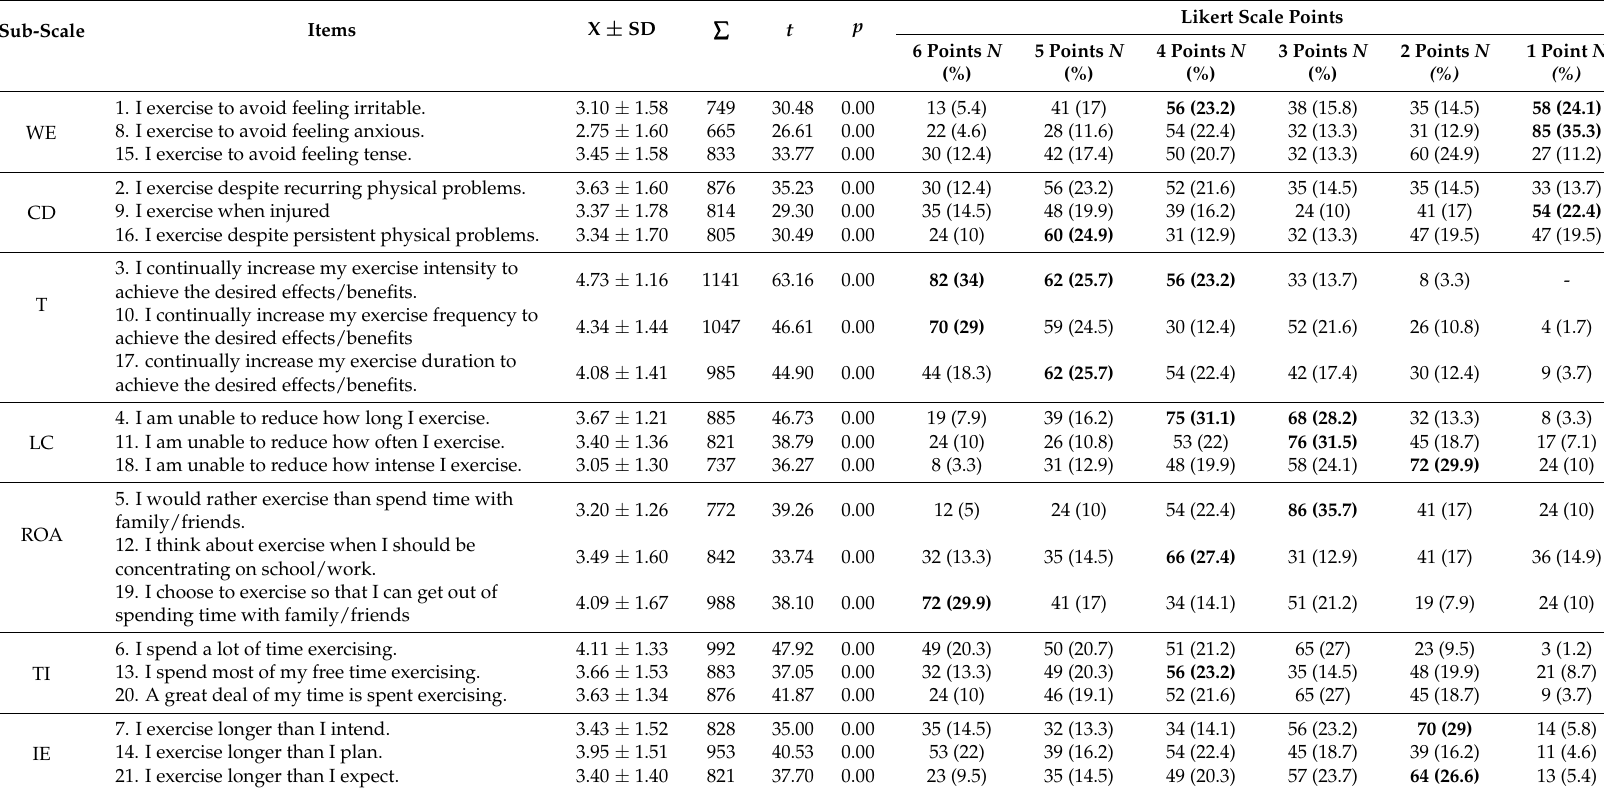
Table 1. The statistical analysis of the average responses according to the Likert scale (6) per item in the questionnaire evaluating the exercise dependence attitudes (EDS-21).